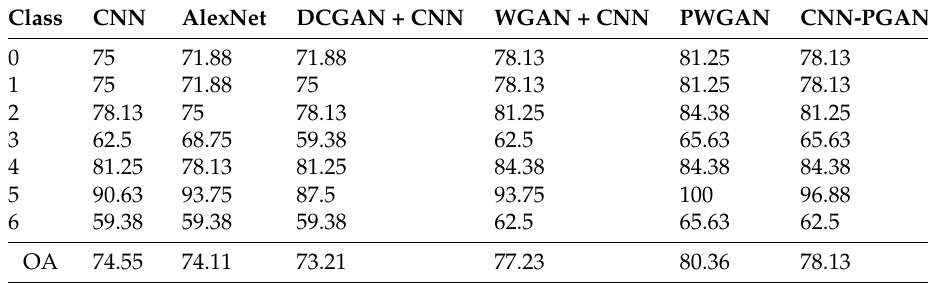
Table 5. The class-specific accuracy (%) and OA (Overall Accuracy) of different methods for DataSet1. DCGAN, Deep Convolutional GAN; WGAN, Wasserstein GAN.